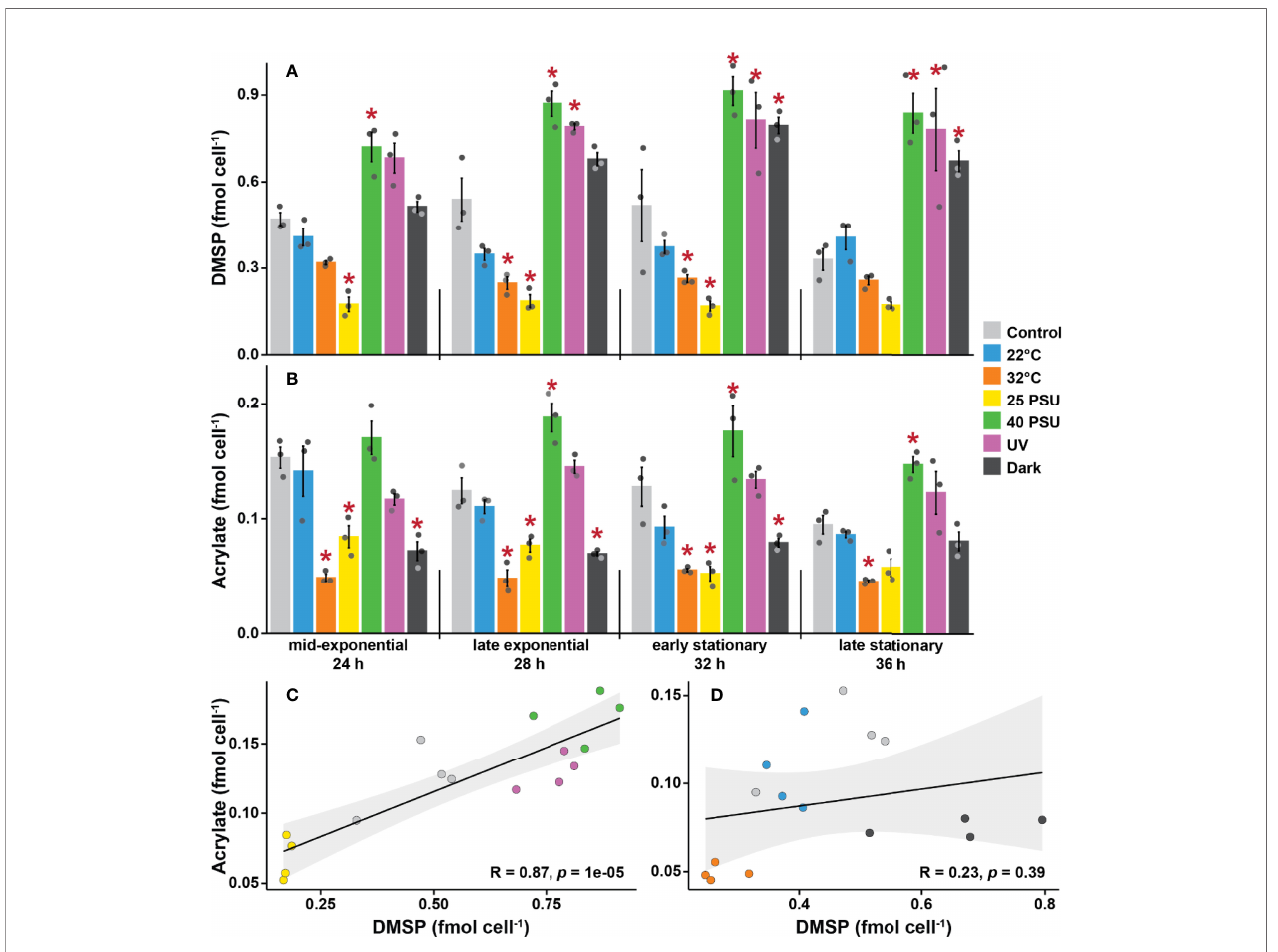
FIGURE 4 | Dimethylsulfoniopropionate (DMSP) and acrylate levels are strongly in fl uenced by environmental stressors in Shimia aestuarii AMM-P-2. Levels of (A) DMSP and (B) acrylate in bacterial cells exposed to high and low temperatures (32 and 22°C), high and low salinity (40 and 25 PSU), constant darkness,